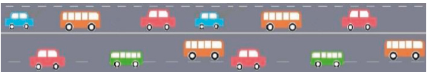
Figure 5: Simulation model of network in linear route.